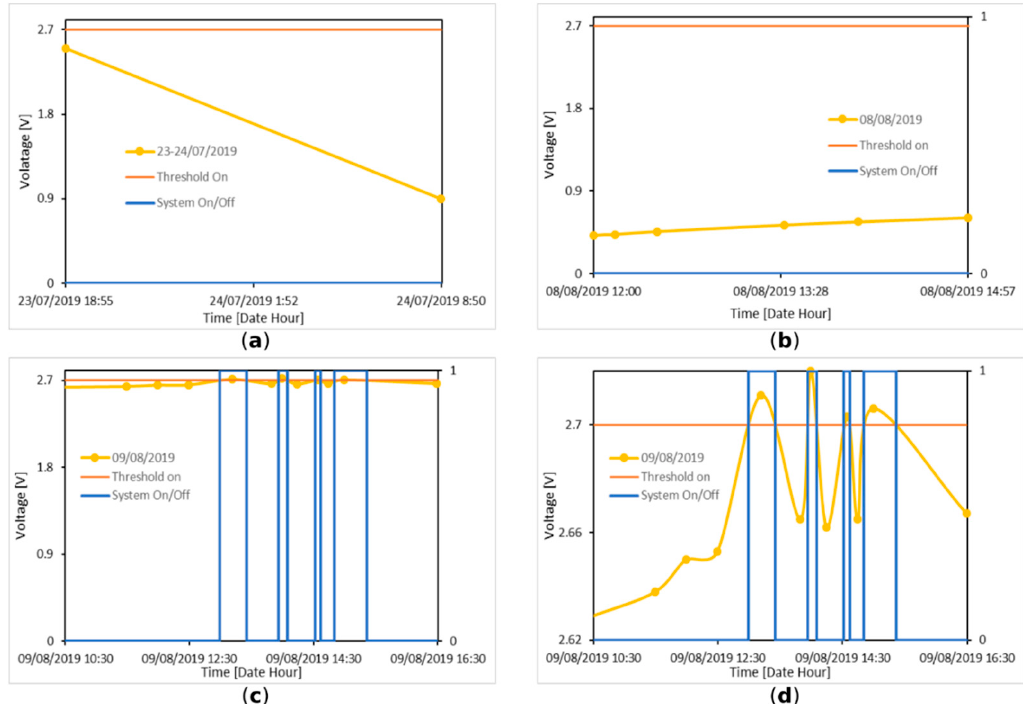
Figure 5. Voltage of supercapacitor with tag in a shady place for solar panel. There are four images that represent how the voltage changes in the supercapacitor for di ff erent days represented by the yellow line. ( a ) Shaded conditions during the night between 23 and 24 July, 2019. The voltage drops because there is no energy source. System is o ff . ( b ) Shaded conditions during 8 August 2019 at noon. The voltage rises but it starts at low value, so this increase is not enough to turn on the system. System is o ff . ( c ) Shaded conditions during 9 August, 2019 at noon as ( b ), but for more hours. The voltage rises and the start point of the voltage is close to the threshold that turns on the system, so the system turns on; however, when system is on it needs more energy, which explains why it always oscillates between on / o ff . ( d ) Reflects the graphic ( c ), but with a delimited voltage range to see the variation in the voltage and the zones in which the system is